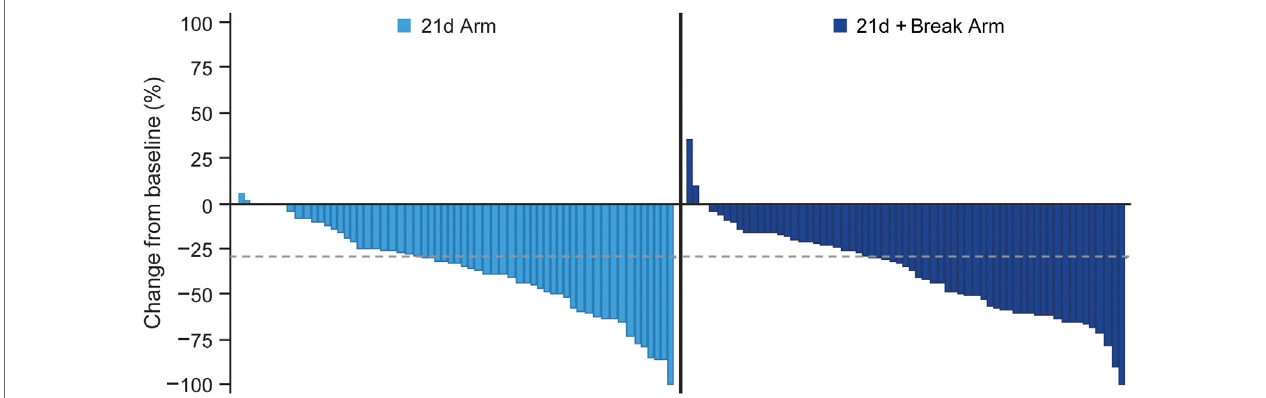
FigUre 3 | Waterfall plot of best percent change from baseline in total length of longest diameters of target